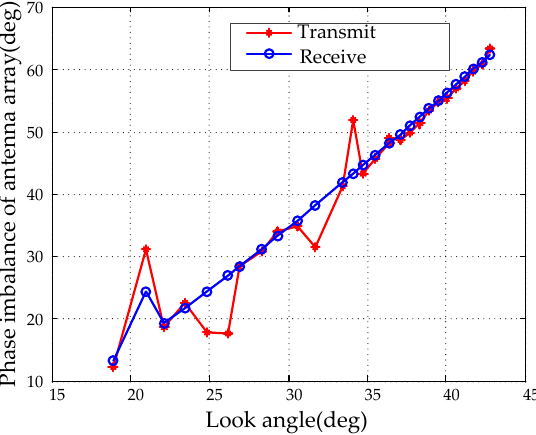
Figure 6. Phase imbalance caused by antenna array under different view angle.